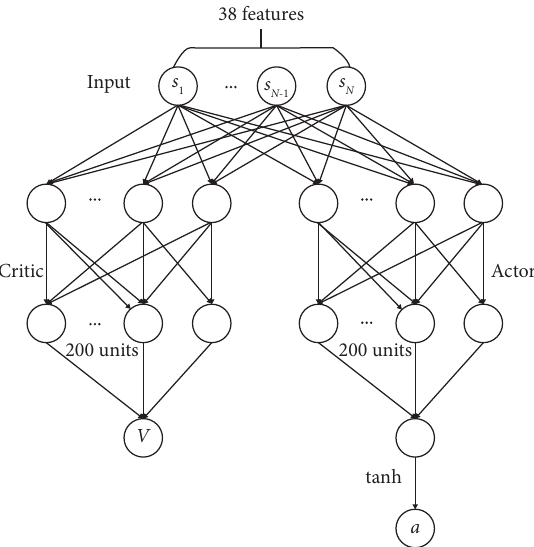
Figure 2: Te architecture of the